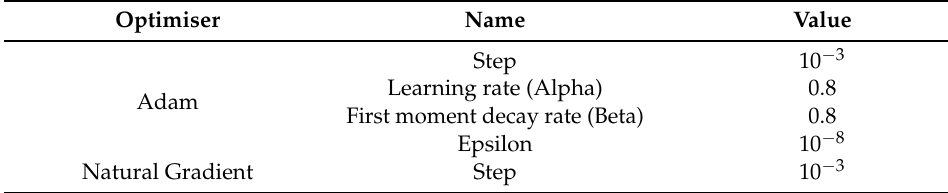
Table 8. Optimisation parameters for the